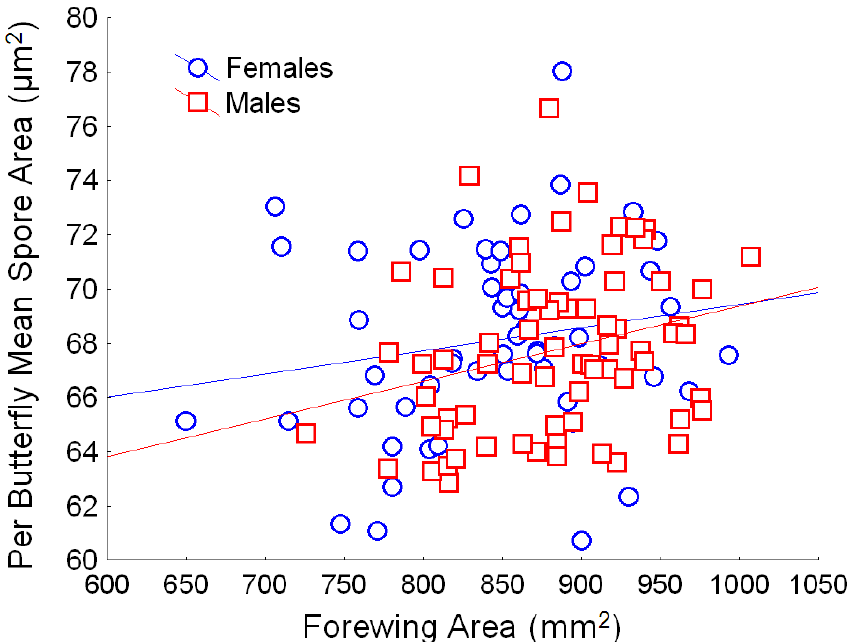
Figure 5. Relationship between butterfly size (forewing area, mm 2 ) and OE spore area (mean per butterfly, in µm 2 ) for males (red) and females (blue). Simple regression relationship (excluding other predictors from the full model) for females: Y = 60.9 + 0.010X; r 2 = 0.032; for males: Y = 55.5 + 0.013X; r 2 =